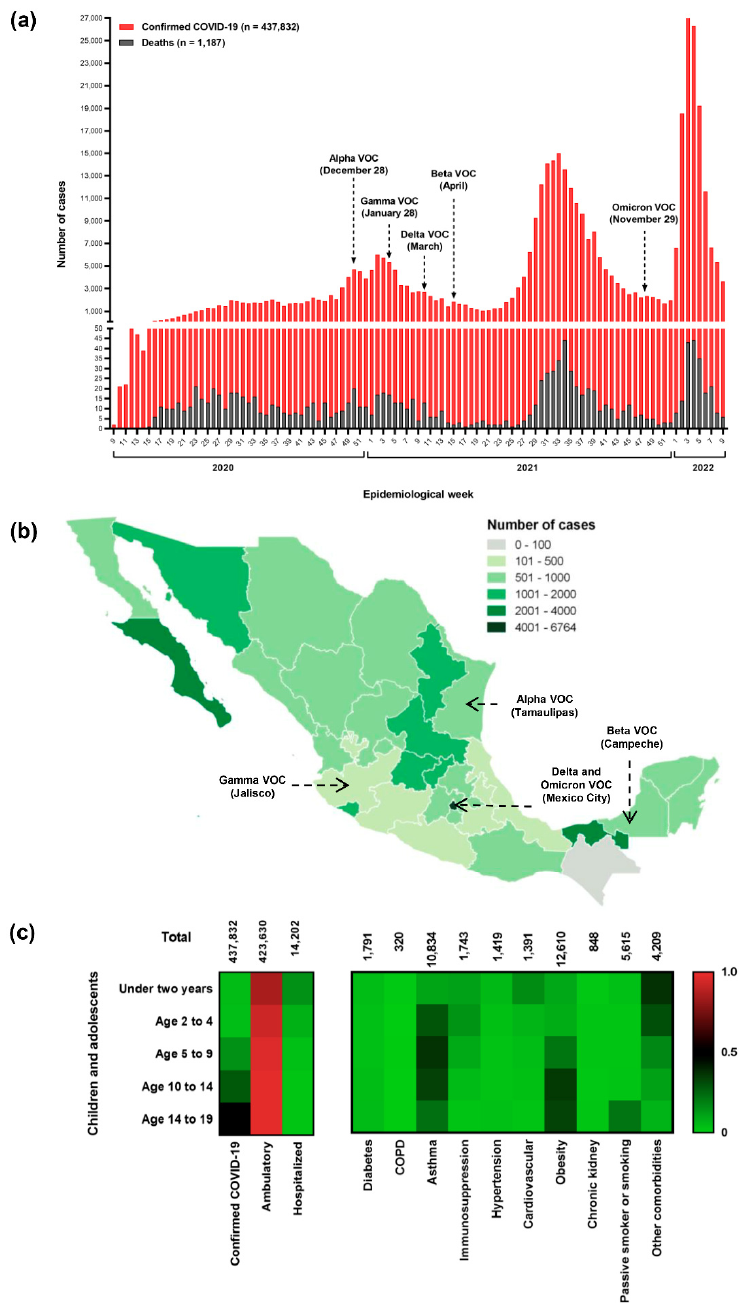
Figure 2. Snapshot of the COVID-19 pandemic in children and adolescents in Mexico: ( a ) temporal incidence of confirmed cases and deaths from COVID-19 from 29 February 2020, to 28 February 2022; ( b ) geographical distribution of the number of cases per 100,000 habitats across the 32 states of Mexico; ( c ) heat map by age group of the clinical presentations of the population analyzed.